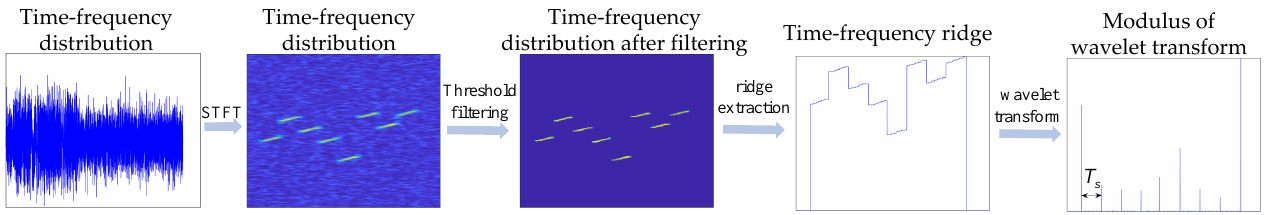
Figure 5. Sub-pulse width estimation